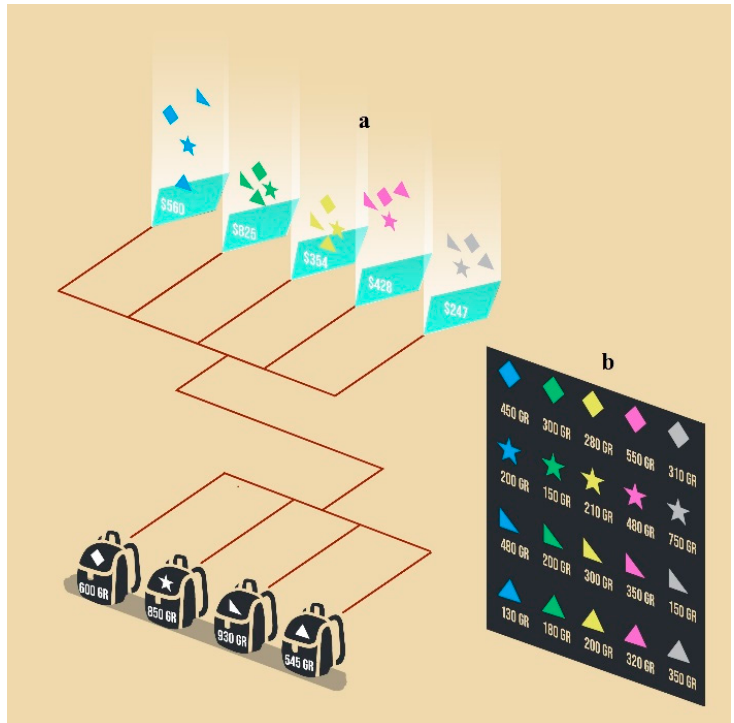
Figure 1. MKP Representation: ( a ) Boxes with a color that have a specific profit; ( b ) figures with different weight. Each knapsack holds just one kind of figure and has a limited capacity.